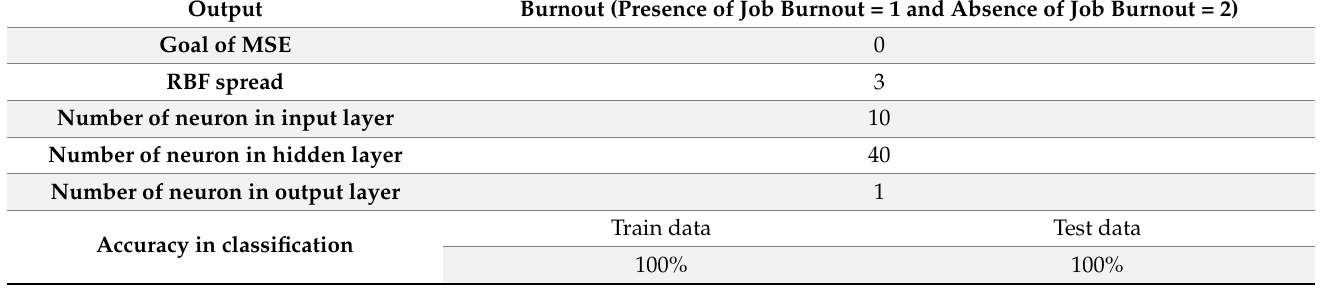
Table 2. Specifications of designed networks.